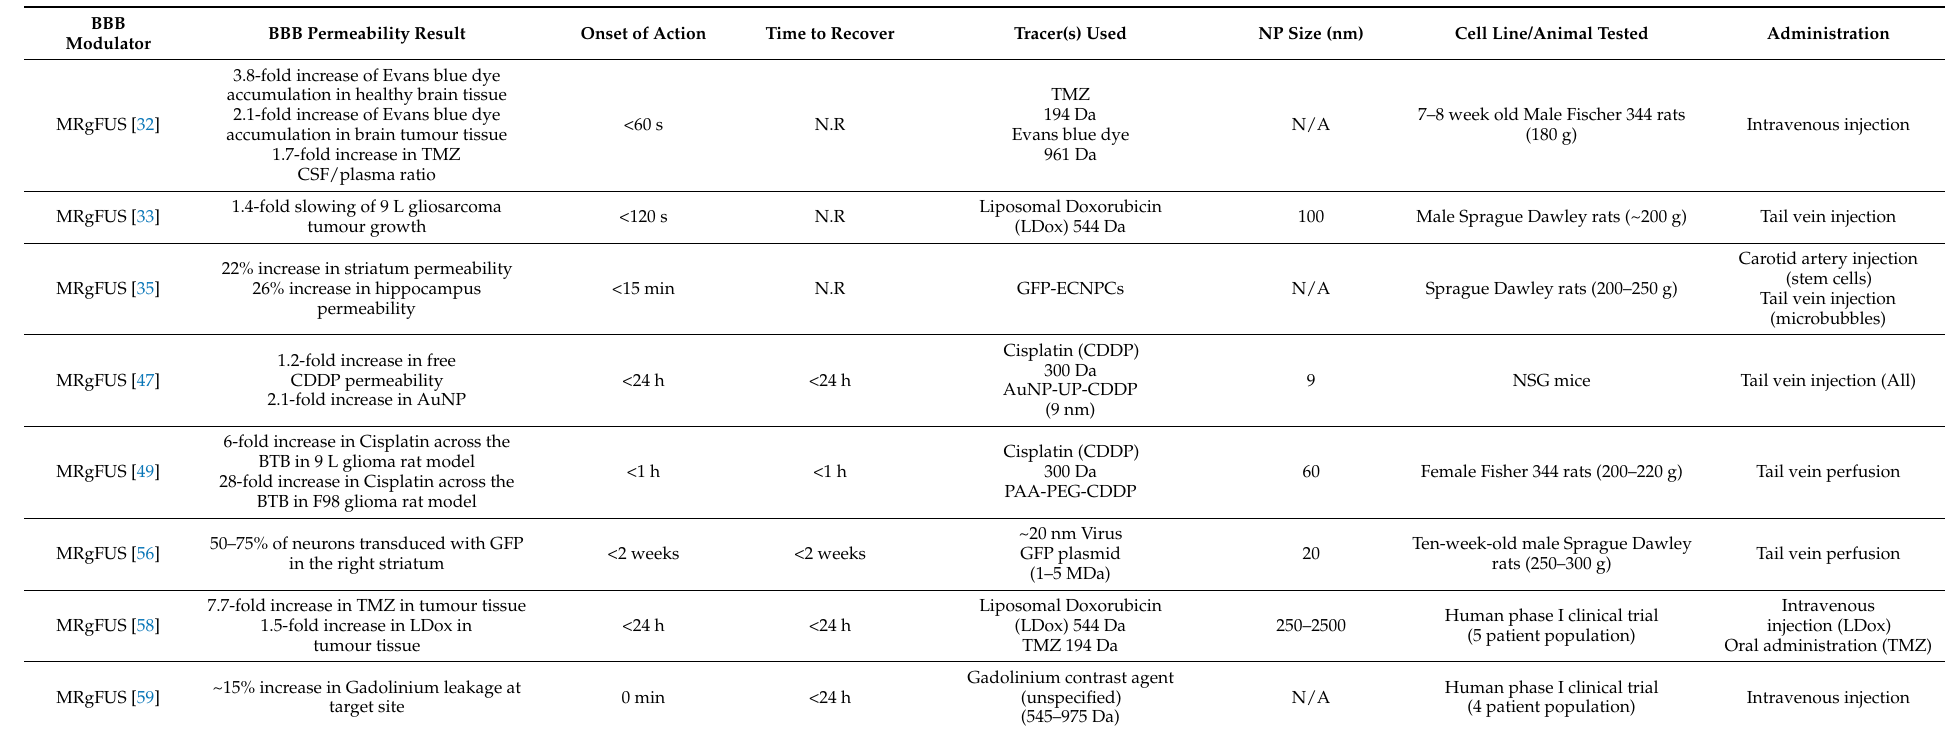
Table 2. Summary of MRgFUS BBB-modulating